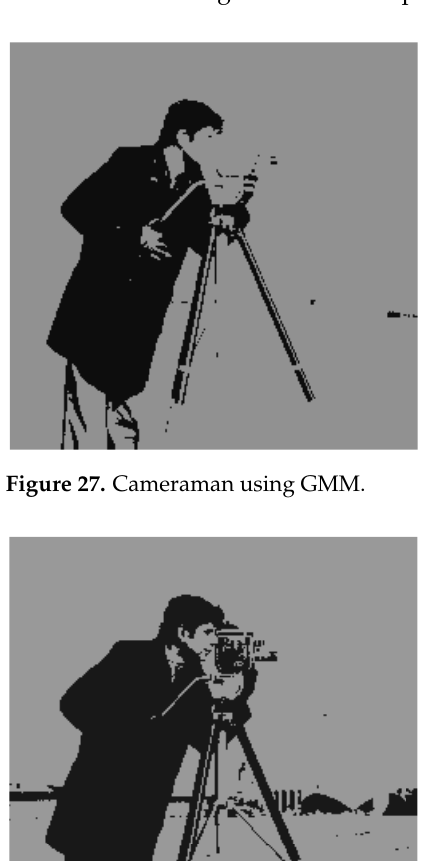
Figure 28. Cameraman using FCM.